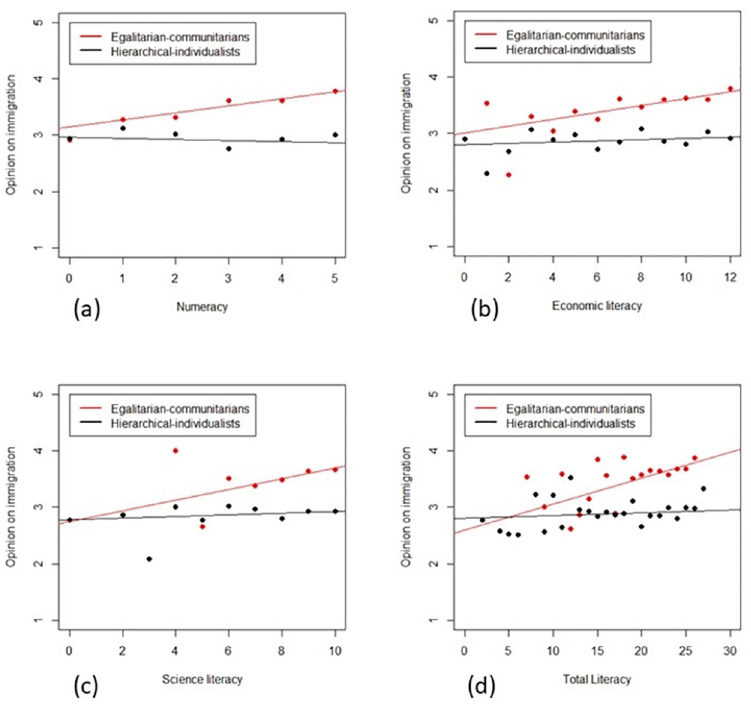
Fig 2. Interactions. Interaction among worldviews with, respectively, numeracy (a), economic literacy (b), science literacy (c), and total literacy (d). Red and black lines represent the fitted values for, respectively, egalitarian- communitarian and hierarchical-individualistic individuals. Red and black dots represent the mean values of perception of immigration for, respectively, egalitarian-communitarian and hierarchical-individualistic individuals.